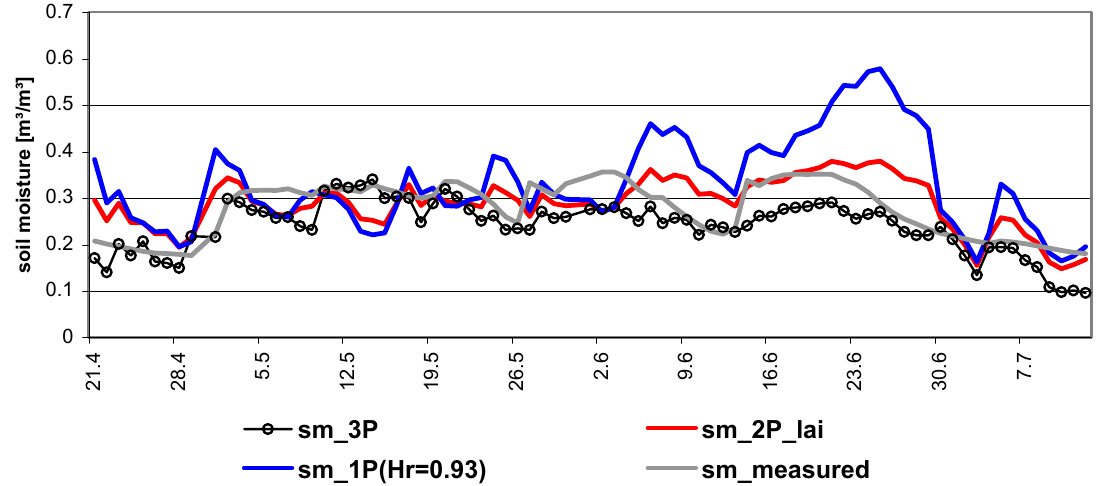
Figure 15. Comparison between the soil moisture of the 3P-retrieval (sm_3P), the 1P-retrieval (sm_1P(H =0.93)) with a constant value of H = 0.93, the 2P-retrieval with tau r r calculated from LAI measurements(sm_2P_lai) and the measured soil moisture at the location